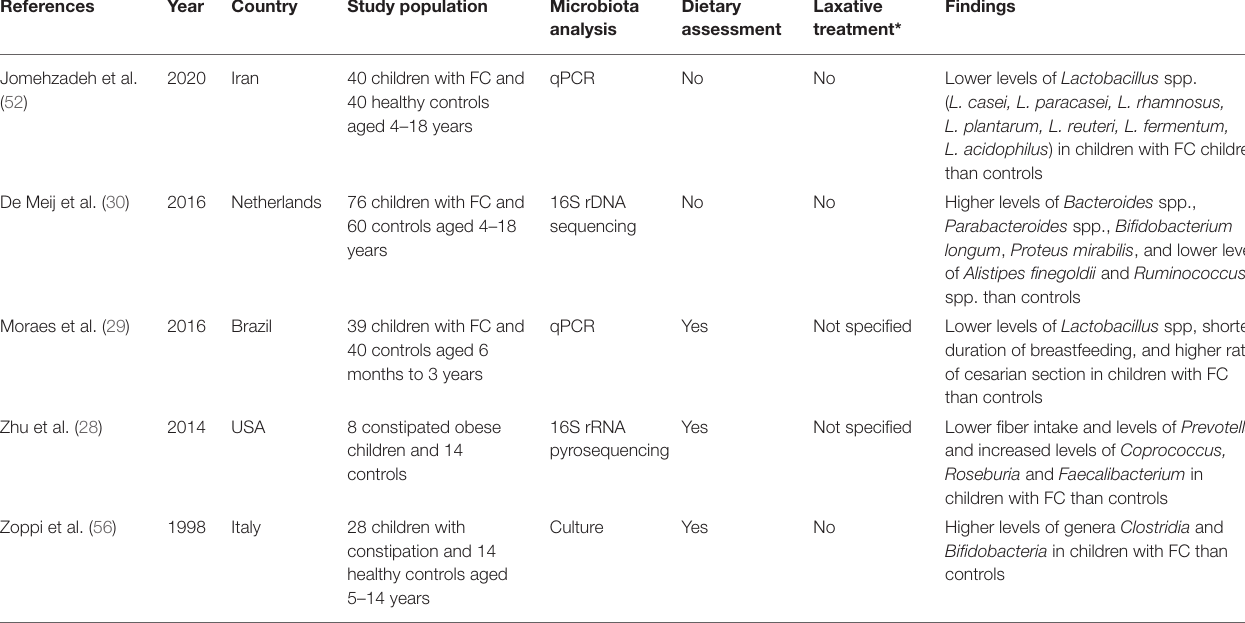
TABLE 1 | Characteristics of studies assessing the gut microbiota of children with